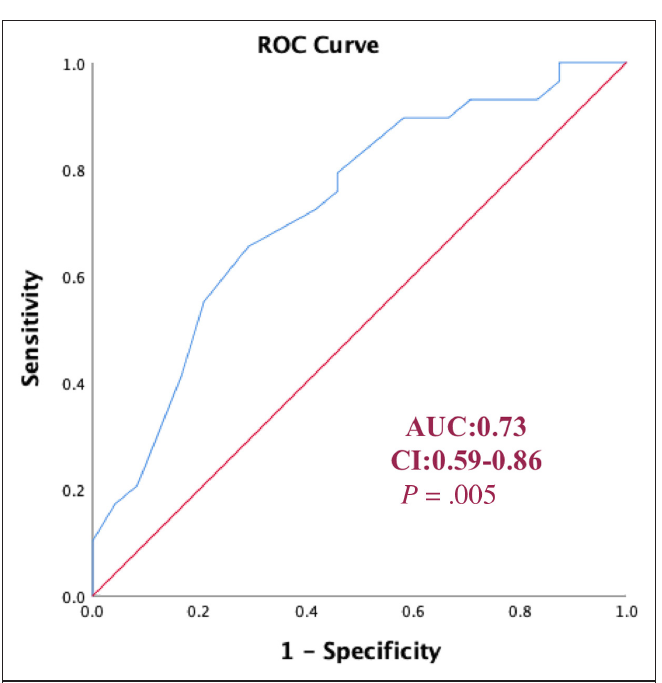
Figure 2. ROC curve analyses showed that PSS > 27.5 predicted insomnia with 66% sensitivity and 71% specificity. AUC, area under the curve; CI: confidence